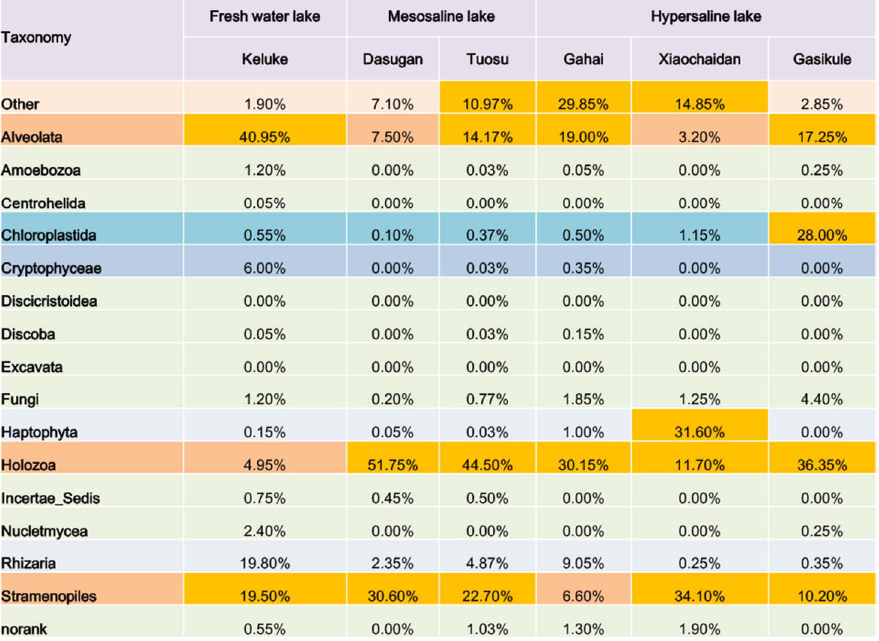
Figure 4. Distribution matrix with the proportion of sequence reads in investigated lakes with different physical and chemical conditions. Taxa were defined at Kingdom level. ‘‘Incertae sedis’’ is a term used for a taxonomic group where its broader relationships are unknown or undefined. ‘‘other’’ means group that could not be precisely assigned to any known eukaryotic taxonomic group. ‘‘norank’’ means group that could not be precisely assigned to eukaryotic taxonomic group at least at the kingdom